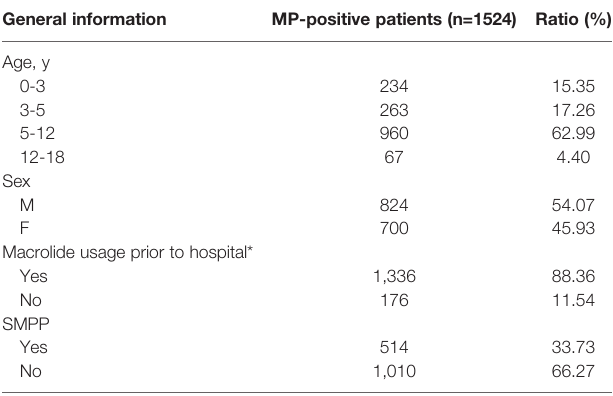
TABLE 1 | Demographic data of MP-positive patients.